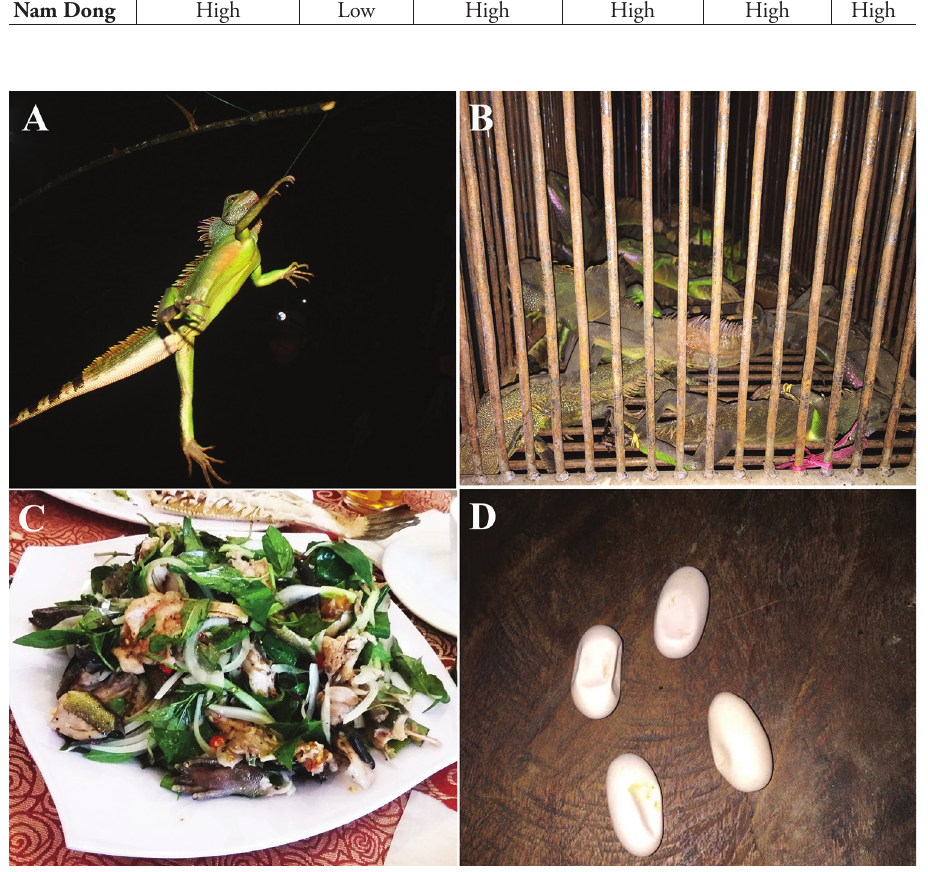
Figure 4. Threats to Physignathus cocincinus in Thua Thien Hue Province: A A trapped individual in Nam Dong District B Specimens collected for food in Hue City C The Asian Water Dragon served as food in a restaurant in Hue City D Eggs of P. cocincinus preserved in alcohol in Nam Dong District.